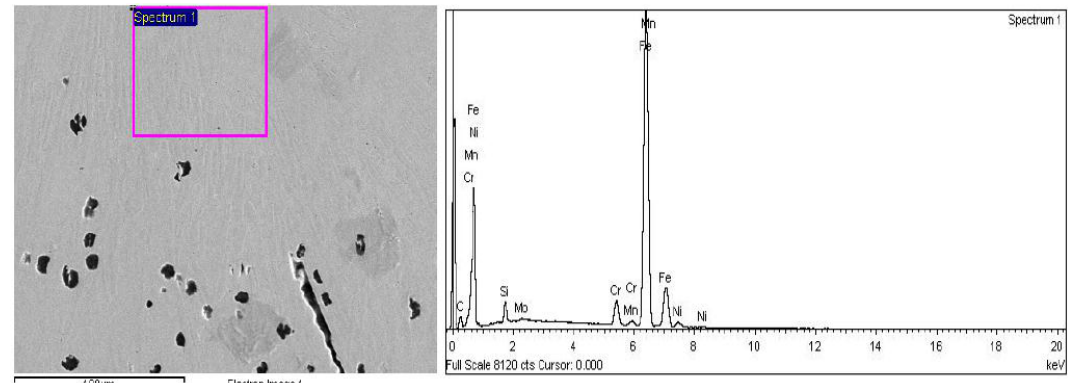
Figure 10. A SEM image and micrograph of the interface zone in a root weld without heat treatment and where a high amount of Cr can be observed in zones welded with Inconel.